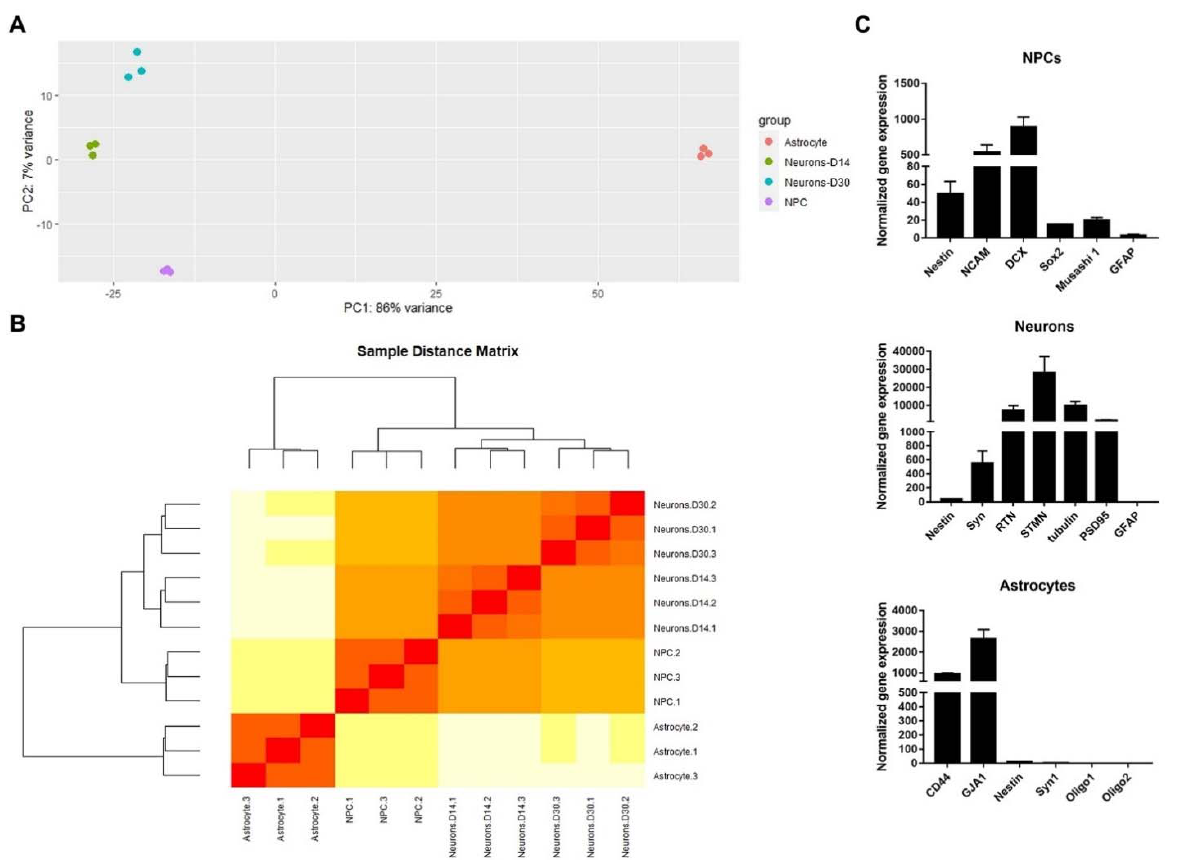
Figure 2. Transcriptomic and gene expression profiles of hiPSC-derived NPCs, neurons, and astrocytes. ( A ) Principal component analysis plot displaying all 12 RNA libraries along PC1 and PC2, which described 89% and 7% of the variability within the expression data set. ( B ) Hierarchical clustering analysis of all 12 RNA libraries based on Euclidian distances using DESeq2 package. ( C ) Gene expression profile of hiPSC-derived NPCs, neurons, and astrocytes quantified by real-time RT-PCR.